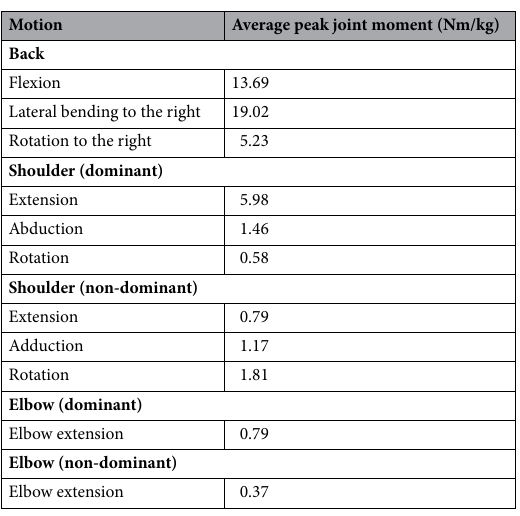
Table 7. Average peak joint moment during